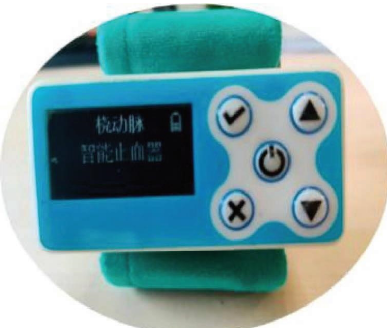
Figure 1: A new radial artery compression device with a pressure control